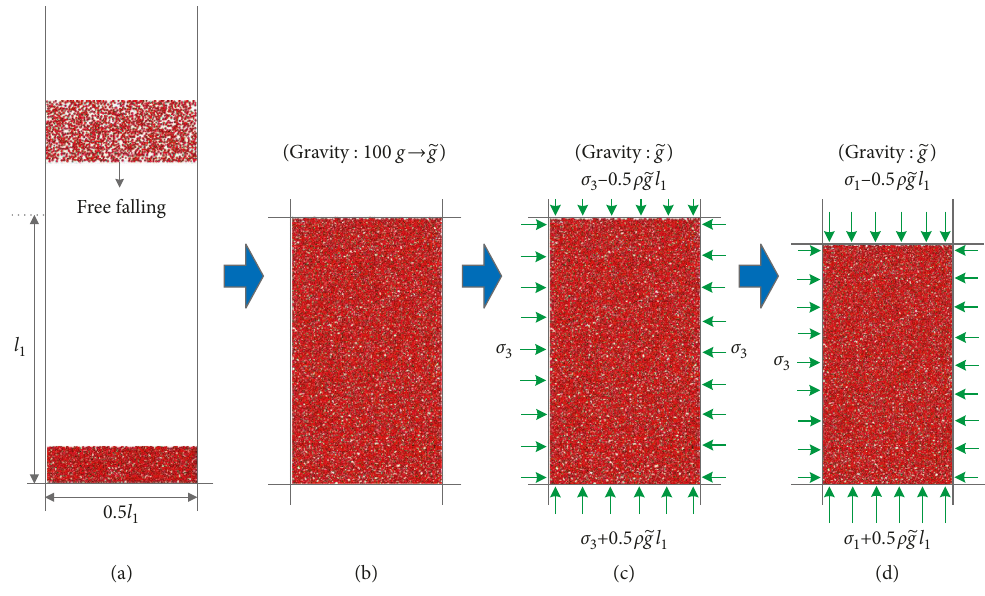
Figure 2: Numerical procedure of the triaxial testing for the RVE. (a) Preparing initial RVE. (b) Unloading gravity. (c) Loading confining pressures. (d) Triaxial loading. Table 2: Testing schedule of the triaxial testing for